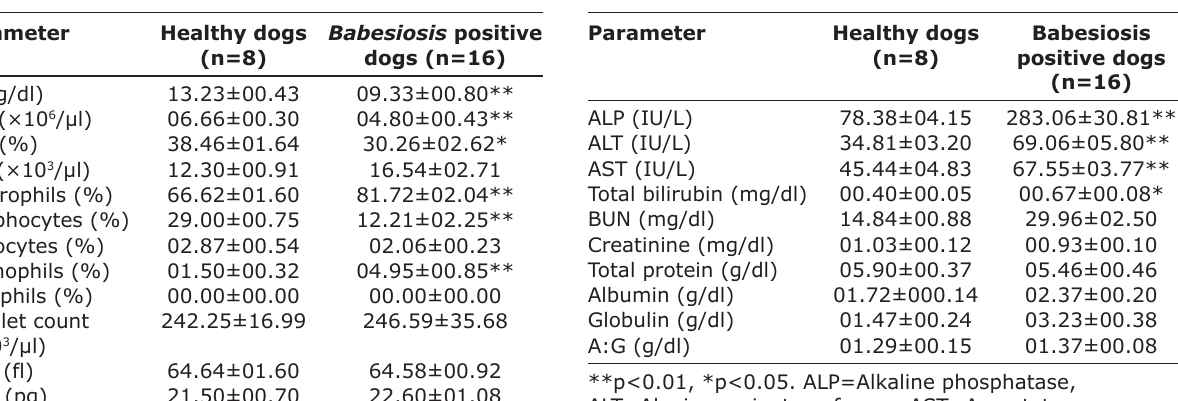
Table-4: Serum biochemical parameters (mean±SE) in healthy and babesiosis positive